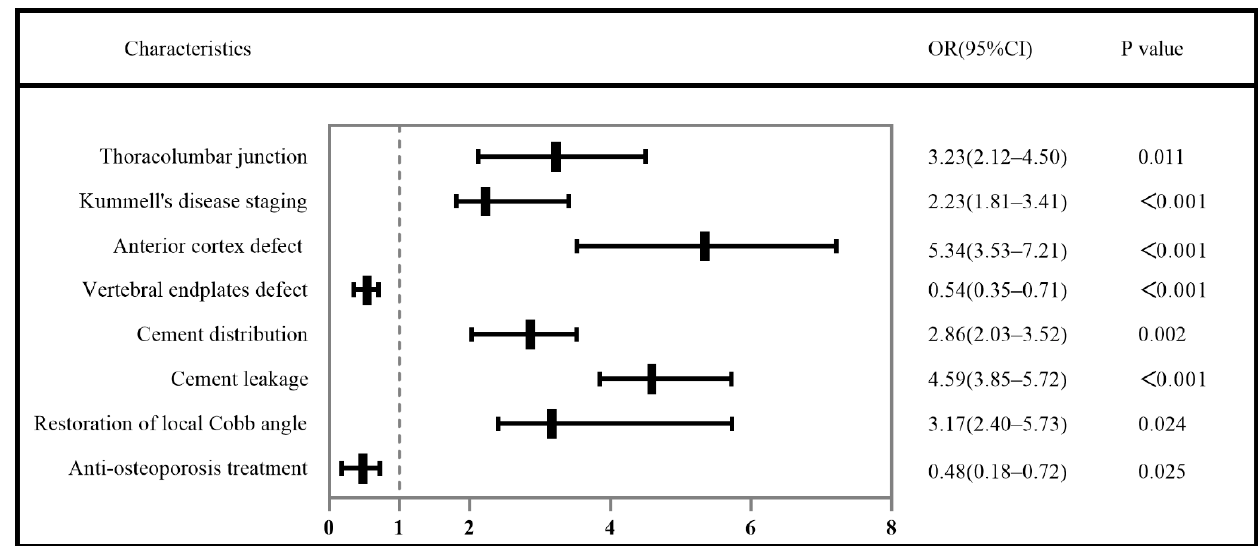
Figure 4. Risk factors of postoperative bone cement displacement in Kümmell’s disease. Table 3. Binary logistic regression correlation analysis for risk factors of bone cement displacement following PVA in Kümmell’s disease.